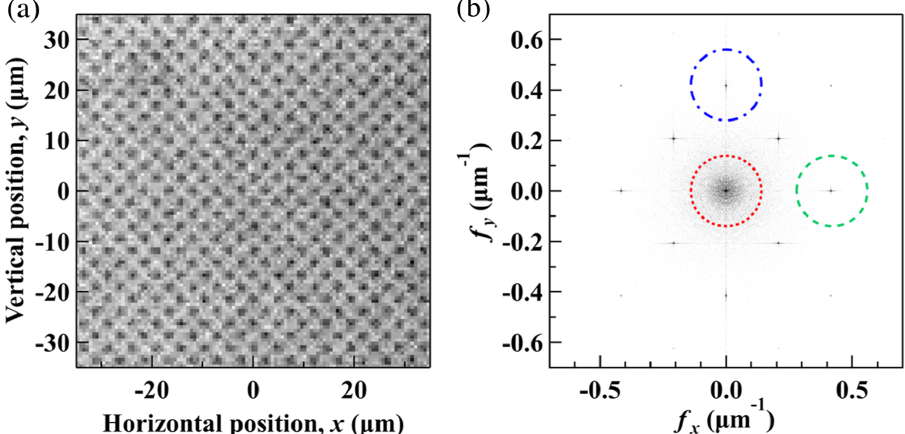
FIG. 4. Measured interferogram (a) and its Fourier-transform image (b) of a π -phase grating at the first Talbot distance.